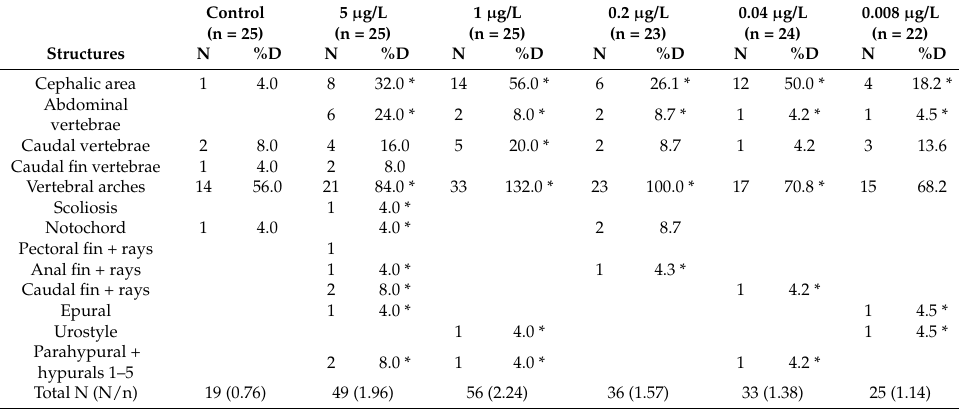
Table 2. Skeletal structures affected upon exposure of zebrafish larvae to cadmium. N, number of occurrences of malformation in the specific structure; %D, percentage of deformed fish in the total population (n); * indicates values statistically different from the control (chi-squared test, 1 degree of freedom, p <